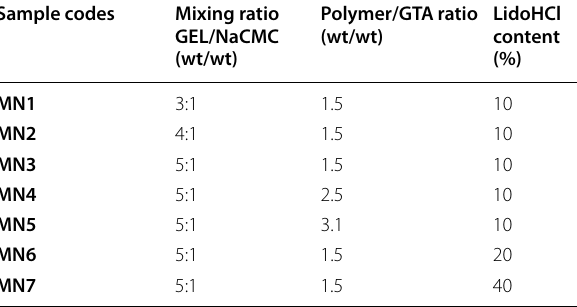
Table 1 Formulation